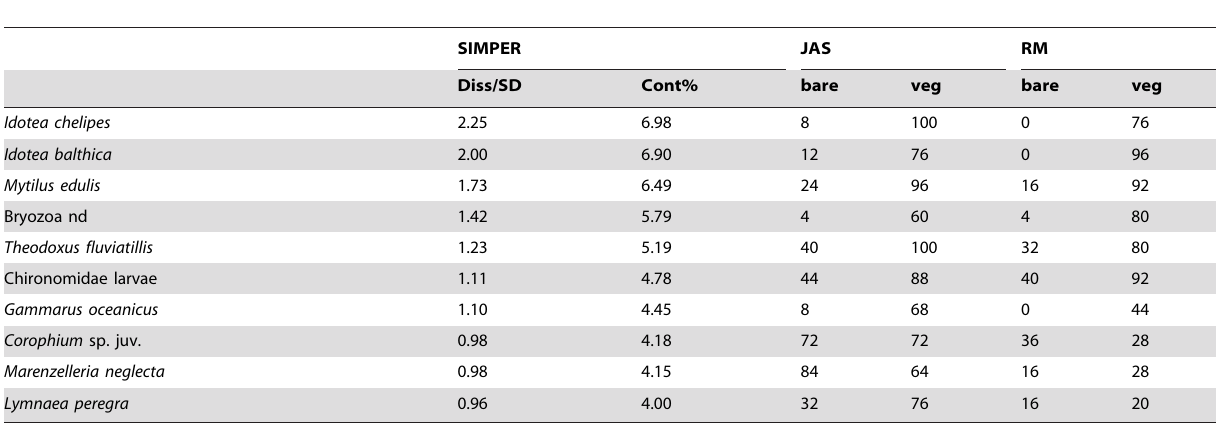
Table 6. Species responsible for discrimination of macrofauna between two bottom types, as indicated by the SIMPER procedure, based on presence/absence